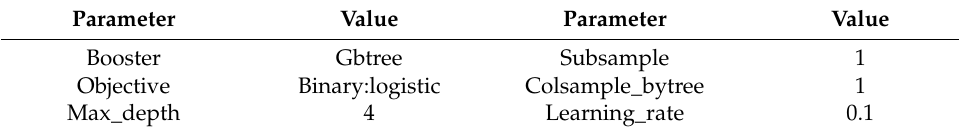
Table 2. XGBoost parameters.